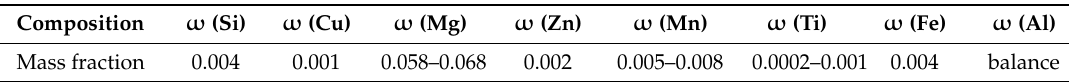
Table 2. Chemical composition of 5A06 aluminum